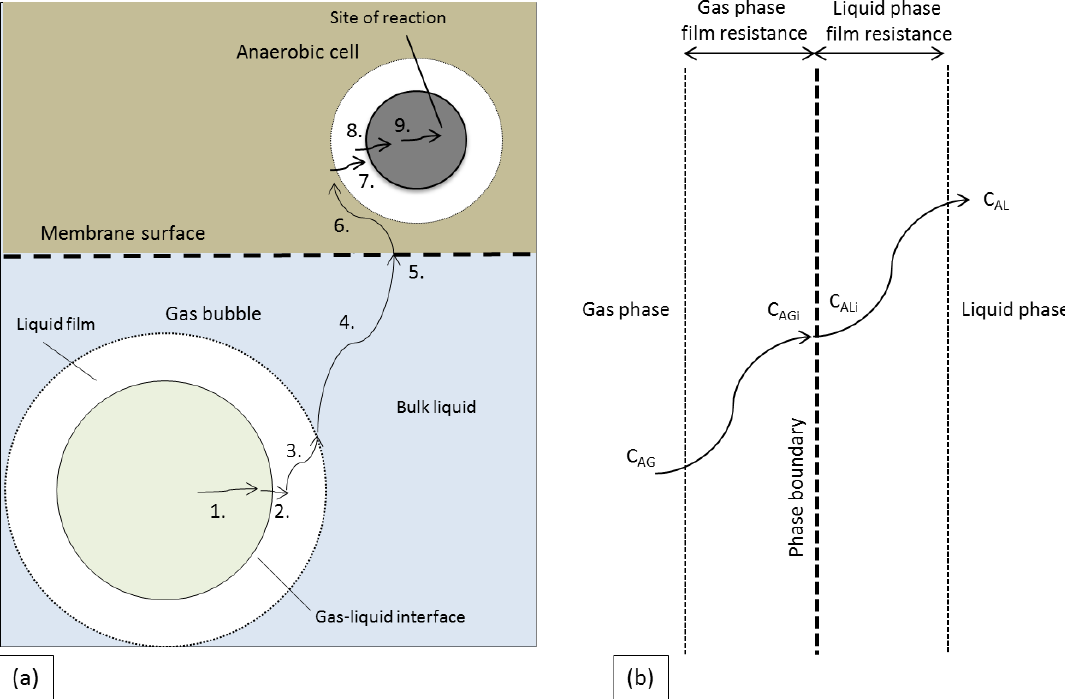
Figure 3. ( a ) The resistances during the mass transfer of syngas from the gas phase to the site of reaction in the cells. 1. Travel in the gas bubble; 2. Move across the gas-liquid interfacial; 3. Travel through the liquid film surrounding the gas bubble; 4. Travel in the liquid bulk; 5. Enter the interior of the membrane through its pores; 6. Move inside the membrane; 7. Travel across the liquid film surrounding the microbial cell; 8. Pass through the cell membrane; 9. Move through the cell and end up in the site of reaction; ( b ) Movement of A through the interfacial boundary. C AL : concentration of A in the liquid phase; C Ali concentration of A in the liquid boundary; C AGi concentration of A in the gas boundary; and C AG concentration of A in the gas phase [14].